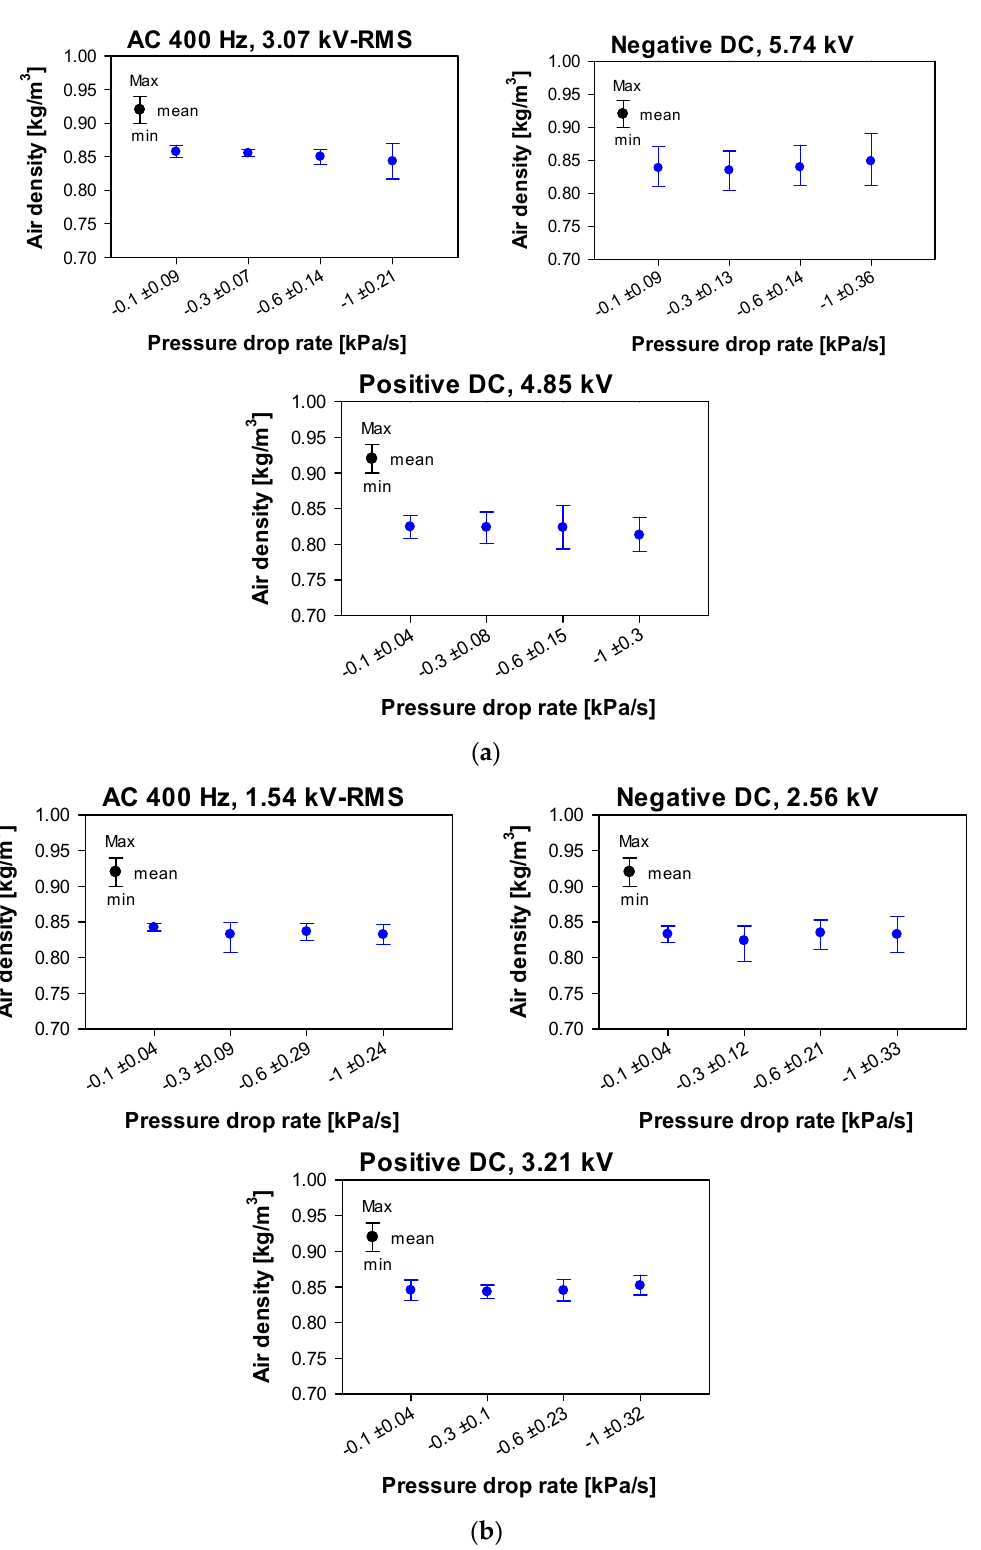
Figure 6. Air density at the instant of corona inception during dynamic pressure tests. ( a ) Electrode #1. ( b ) Electrode